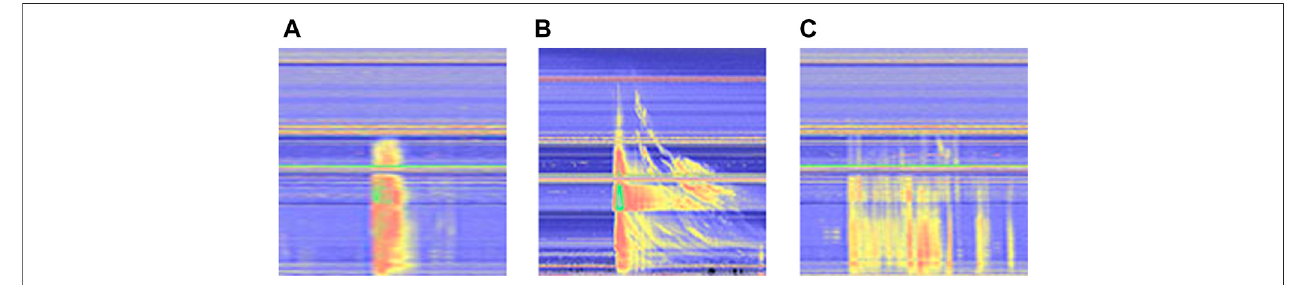
FIGURE7| Three cases that havebeen misidenti fi ed astype VbyC-GCGAN. According tothe onlinedata log fi le, (A) hasbeen classi fi ed astype III, (B) astype III, and (C) as type III.